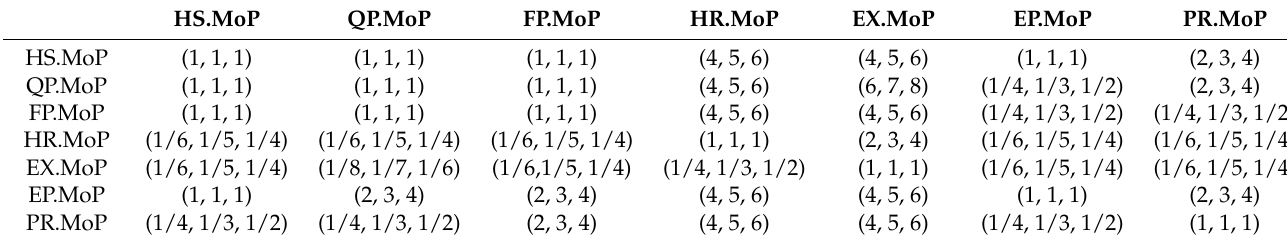
Table 6. Pairwise comparison matrix of expert